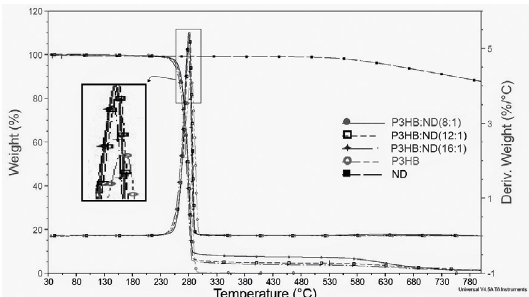
Figure 1: TGA curve for the three distinct formulation (green curve: P(3HB):ND(8:1); blue: P(3HB):ND(12:1); purple: P(3HB):ND(16:1)). Table 1: Comparison of ND load for each formulation presented by TGA and on the solution before encapsulation. Formulation